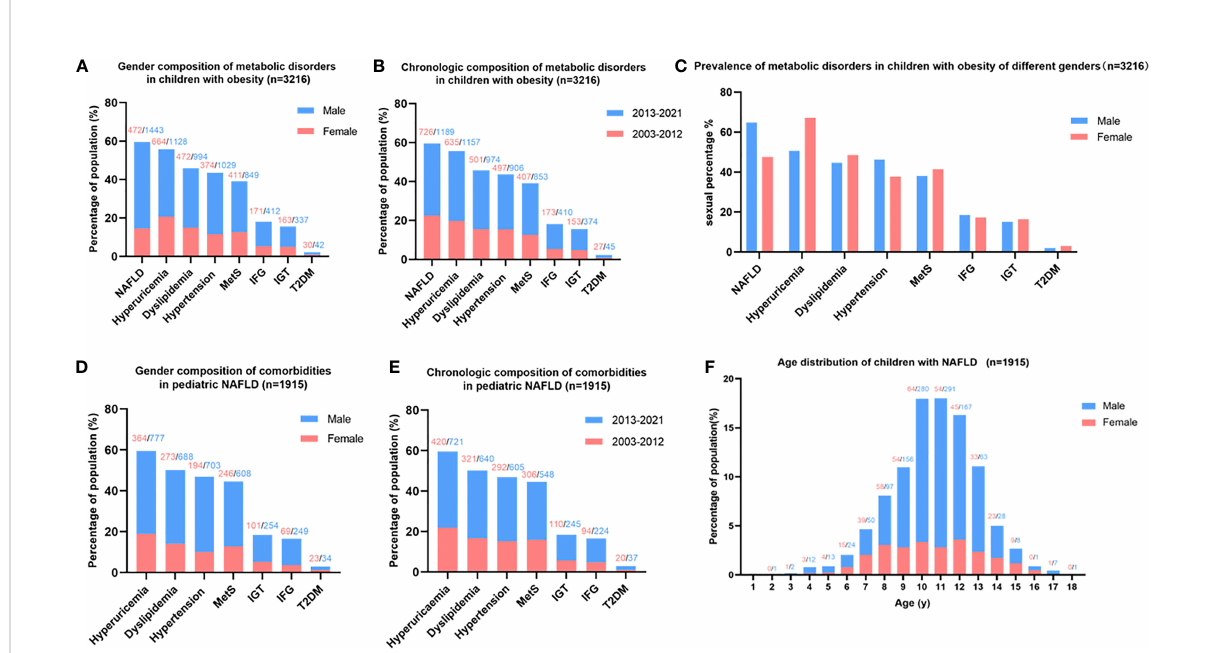
FIGURE 2 Metabolic spectrum of childhood obesity and comorbidities of pediatric NAFLD. (A) Gender composition of metabolic disorders in children with obesity: NAFLD is the most common complication of childhood obesity, more males suffered from obesity and metabolic disorder than females. (B) Chronologic composition of metabolic disorders in children with obesity: The prevalence of obesity and metabolic disorders in children has been increasing in recent 19 years. (C) Prevalence of metabolic disorders in children with obesity adjusted by gender: the prevalence of NAFLD and hypertension was much higher in males than females, while hyperuricemia was much more prevalent in females than males. (D) Gender composition of comorbidities in pediatric NAFLD: hyperuricemia ranked top one comorbidities of childhood NAFLD. (E) Chronologic composition of comorbidities in pediatric NAFLD: The prevalence of comorbidities of pediatric NAFLD has been increasing in the last 19 years. (F) Age distribution of children with NAFLD: the peak onset age of childhood NAFLD is 10-12 years old. Note: the number on the top of the fi gure indicates the count of patients, red represents females, and blue represents